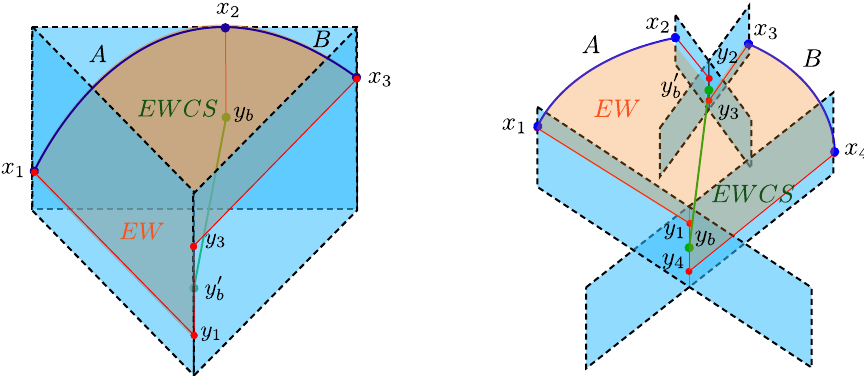
Figure 8: Boundary intervals (left: adjacent, right: non-adjacent) and their entan- glement wedge. The red lines emanating from the boundary points x (= 1,2,3,4 ) are the endpoints of relevant RT surfaces connecting lines γ . Here y i i γ . y and y (cid:48) are the endpoints of the EWCS (green), which is the saddle geodesic i b b connecting those RT surfaces. In the left figure, y are inspired by [ 83 ]